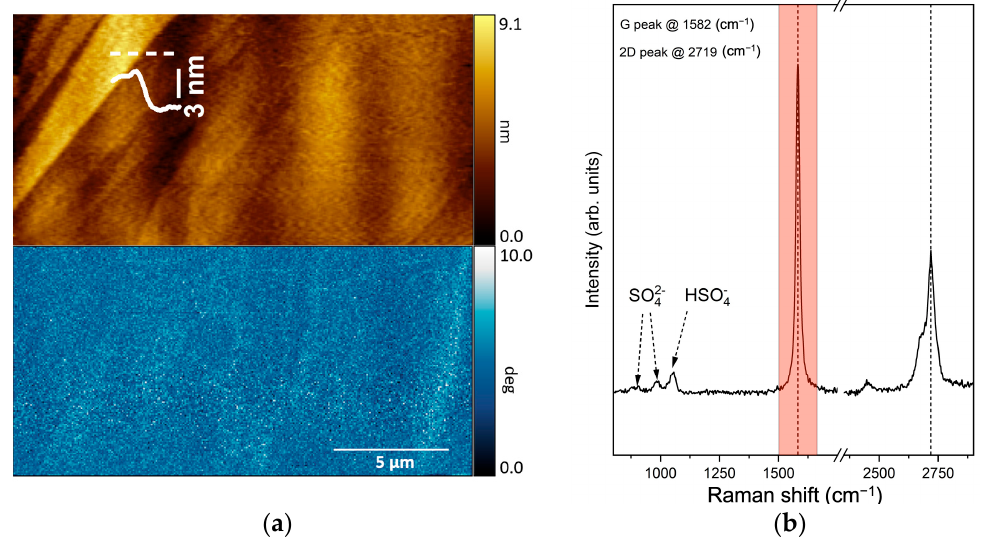
Figure 3. ( a ) A (20 × 20) μ m 2 AFM topography (upper panel) and the phase-contrast image (lower panel) of the HOPG electrode immersed in 1 M H 2 SO 4 electrolyte with the sample biased at 300 mV with respect to the reference electrode (see the text for more details). ( b ) Raman spectrum acquired in a point inside the scanned area reported in panel a. The red region highlights the G peak feature.